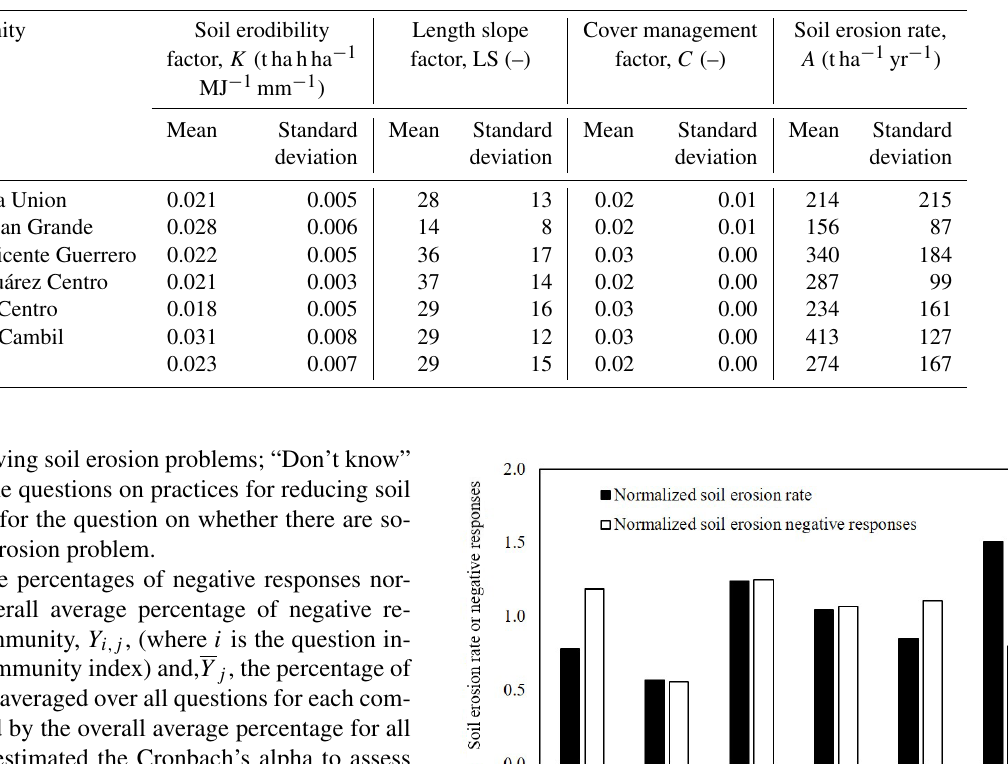
Table 2. RUSLE factors and model results.